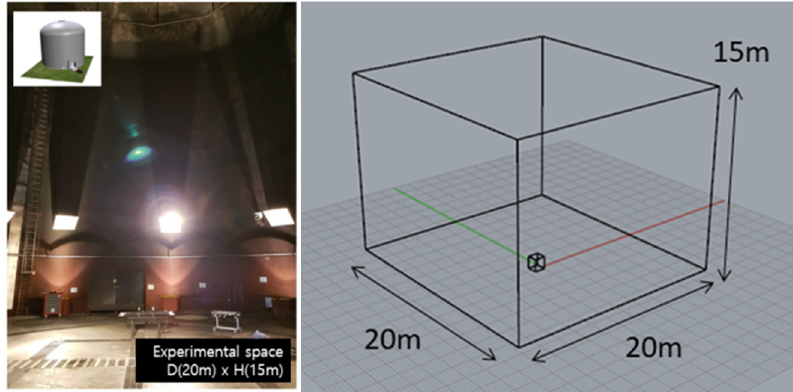
Figure 10. Schematic of simulation model with photograph for comparison.